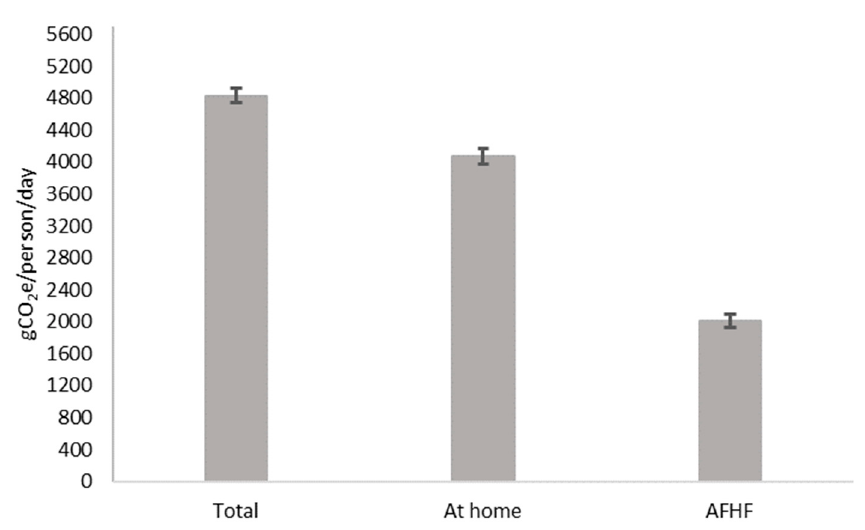
Figure 1. Mean and 95% confidence interval of energy-adjusted carbon footprint (gCO 2 e/person/day) of food consumption according to place of consumption. Brazilian adults in urban areas, 2017–2018 (n = 22,780).